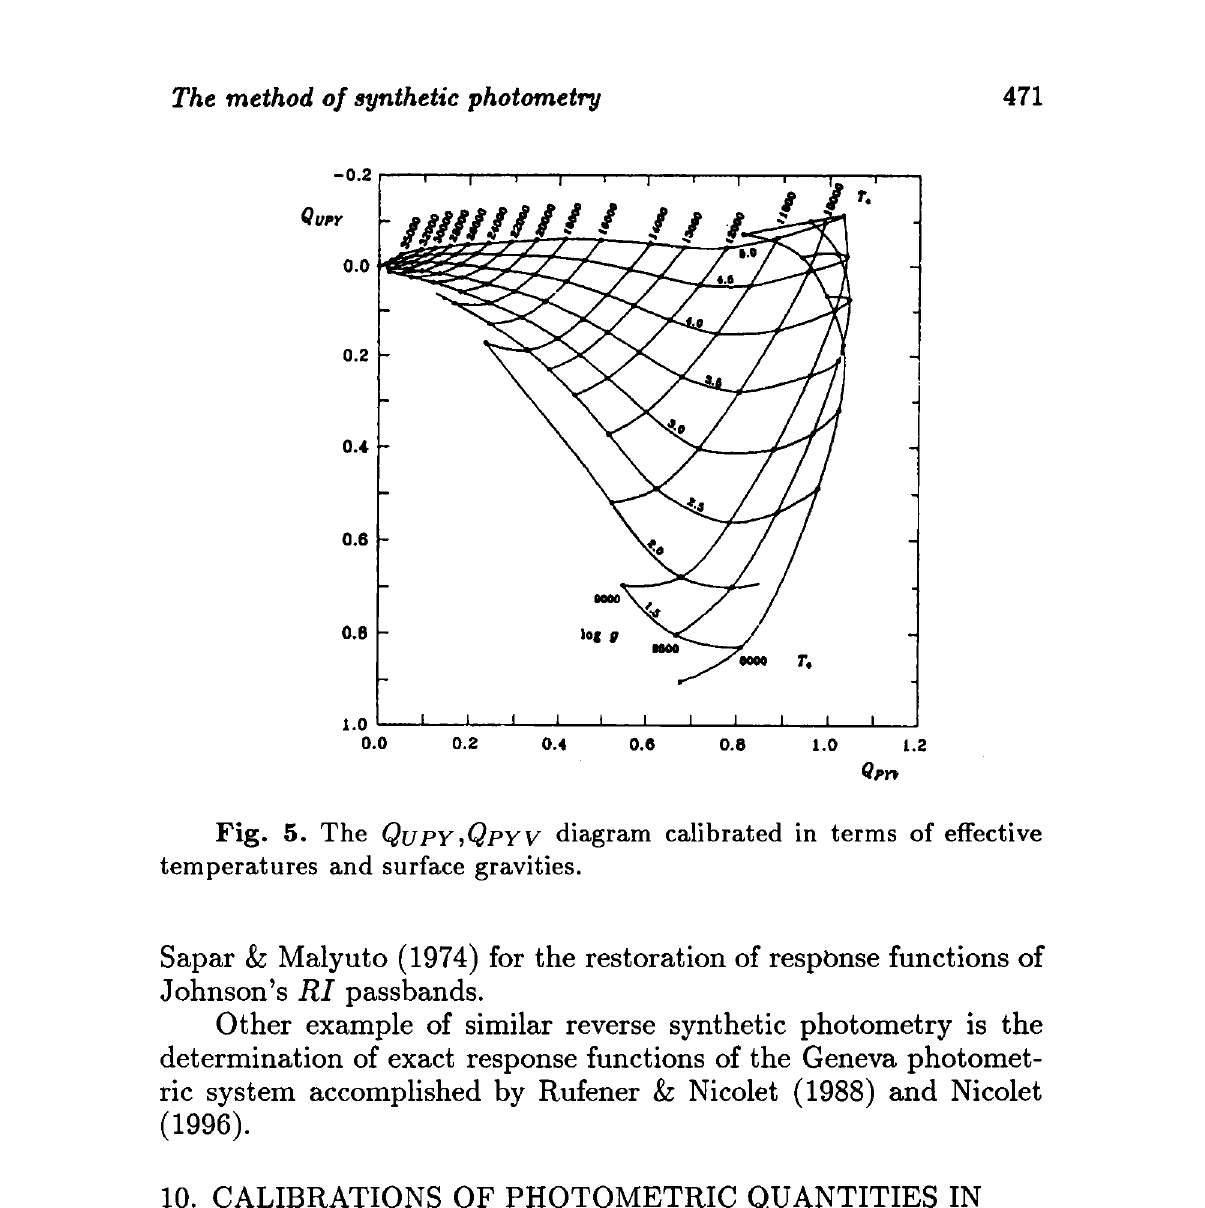
Fig. 5. The QUPY,QPYV diagram calibrated in terms of effective temperatures and surface